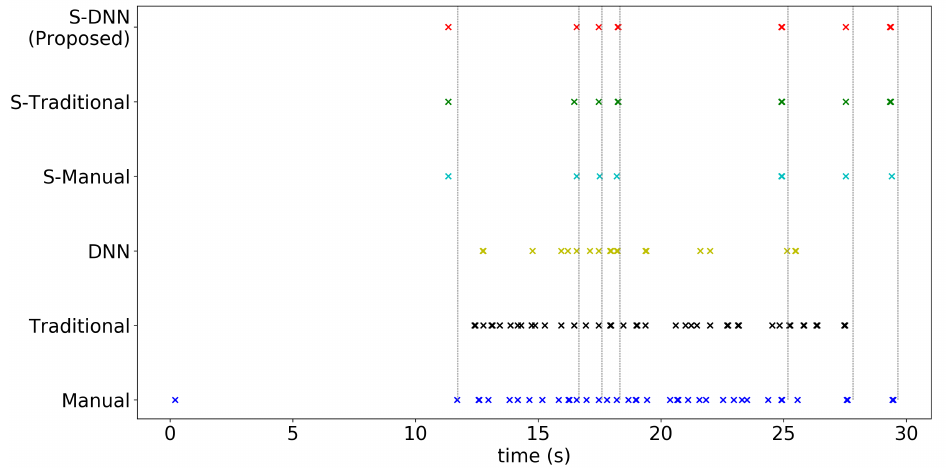
Figure A9. Prediction consistency of event counting compared with ground truths for capillary 3.